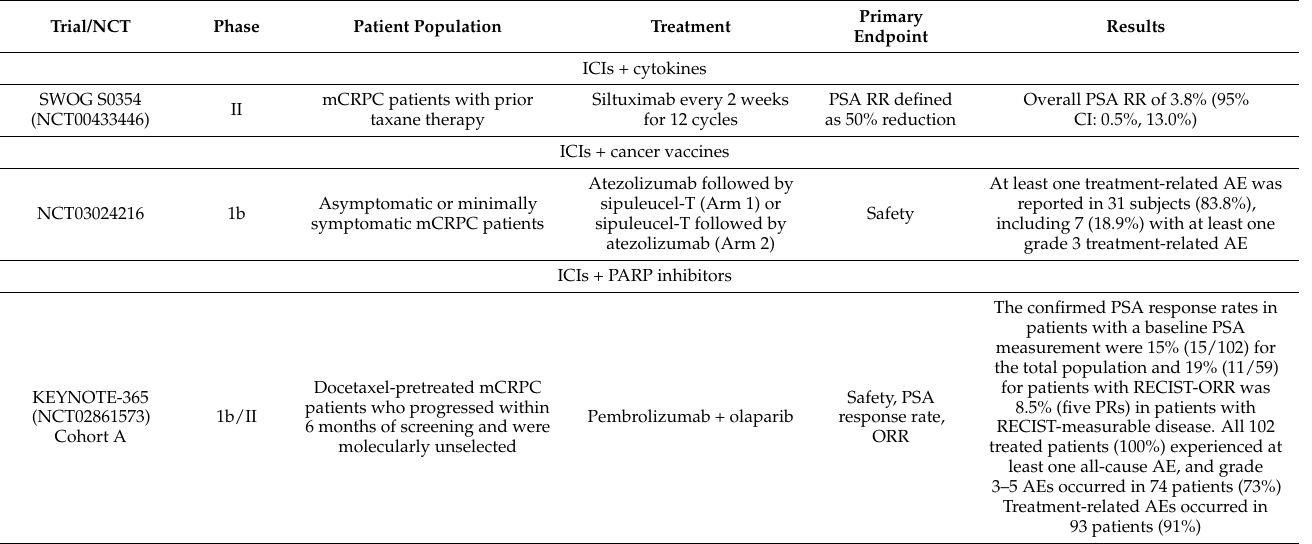
Table 3. Combination strategies and targets with ICIs in